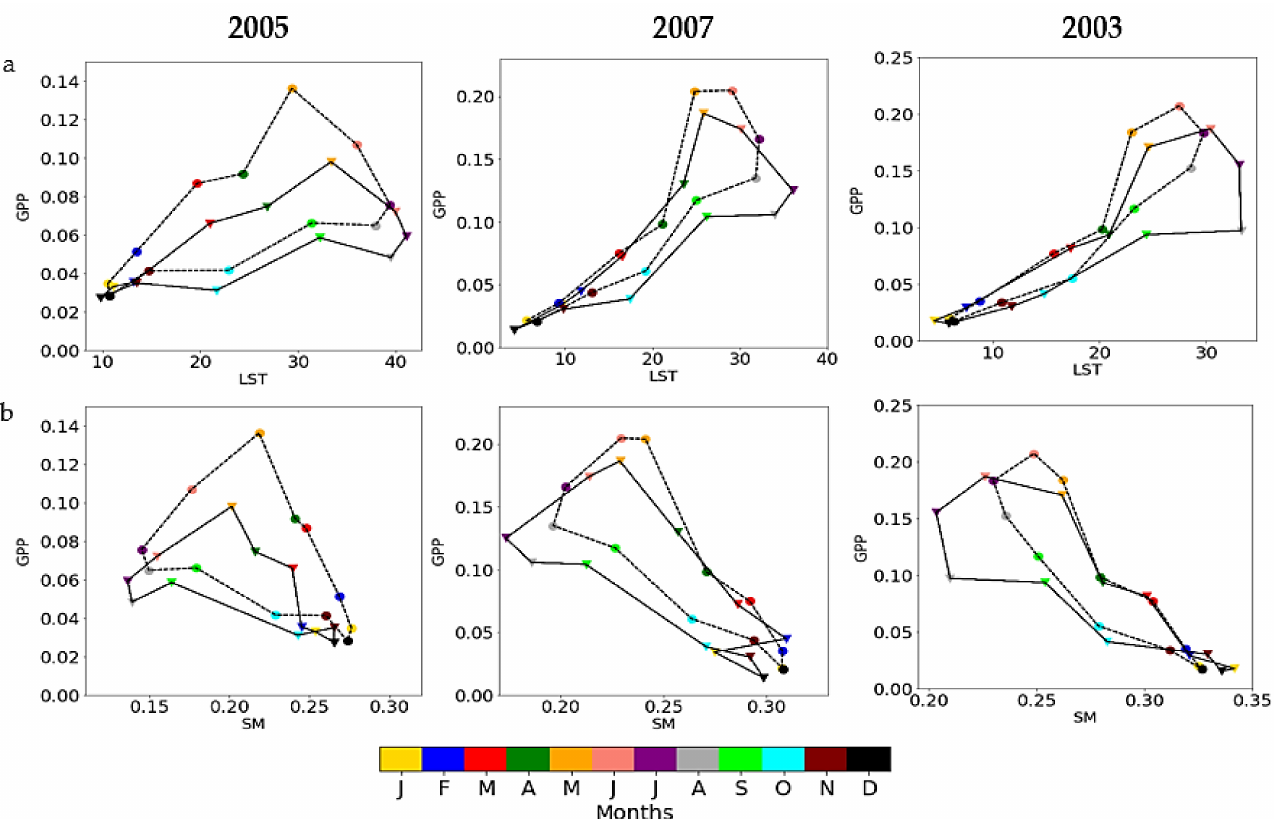
Figure 4. Monthly median cycle (black dashed line) and seasonal cycle (black bold line) of the ecological extreme of the IB 2005 event (left panels), EM during the 2007 event (central panels) and WE during the 2003 event (right panels): ( a ) LST (xx axis) vs. GPP (yy axis); ( b ) SM (xx axis) and GPP (yy axis). Months are represented by circles in the monthly median cycle and by triangles in the seasonal cycle of the extreme event. Each month is illustrated by a different colour according to the colour bar. GPP is expressed in kg C/m 2 /month, LST in Celsius and SM is expressed in m 3 /m 3 .